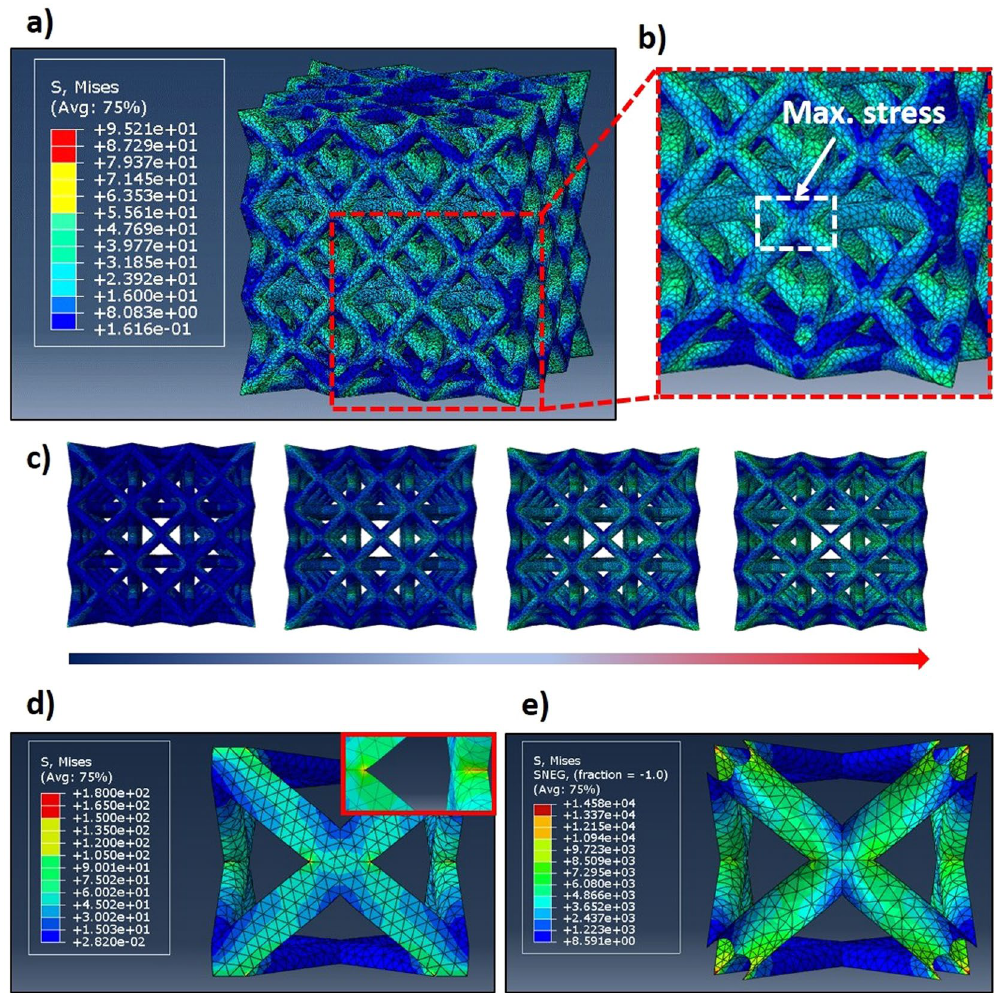
Figure 4. Uniaxial compression tests performed on the polymer and HEA-coated microlattices. ( a ) Layer- by-layer buckling deformation behavior of polymer microlattice. ( b ) Deformation and fracture progression of HEA-coated microlattice during compression. ( c ) Stress-strain curves of the polymer and composite microlattice which were tested under the same environmental and experimental conditions. ( d ) Loading- unloading compression tests performed on the polymer and composite microlattice in the elastic region. ( e to h ) Fracture surface morphology of HEA-coated microlattice after